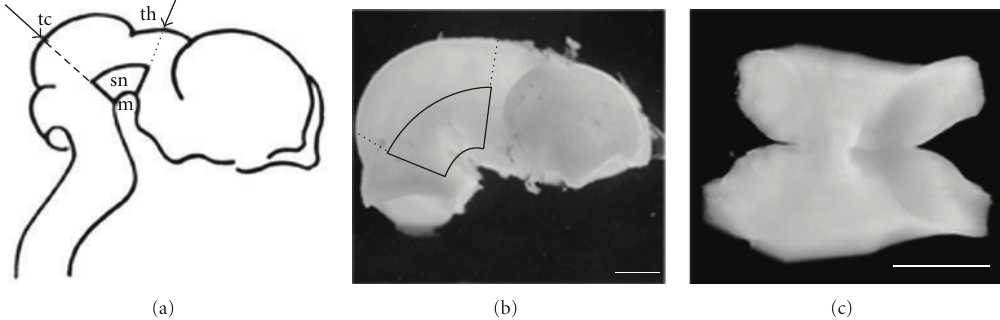
Figure 1: Dissection of porcine embryonic (E28–30) ventral mesencephalon (VM). (a) Lateral perspective showing the angle of the first two cuts of the dissection, with imaginary lines (arrows) intersecting the dorsal surface of the tectum (tc) and the thalamus (th) (from Dunnett and Bjorklund, 1992). (b) Brain of a 28-day-old embryo with the dissection lines from (a) marked. The area encircled by solid lines represents the VM. (c) The ventral surface of the isolated VM explant. Scale bars: 500 μ